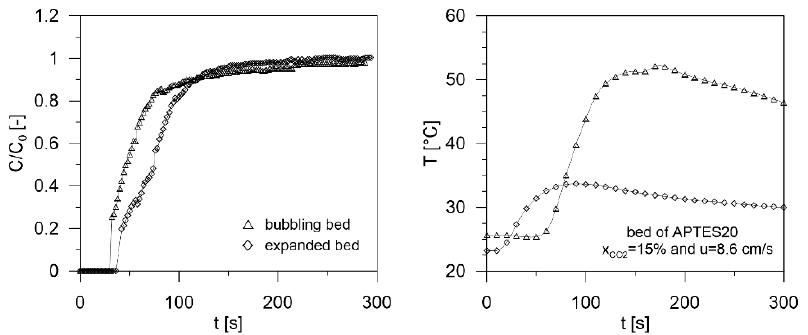
Figure 15. The breakthrough curves of APTES20 at a fixed velocity (5.6 cm/s) and concentration (15% CO 2 ) for both contact modes.